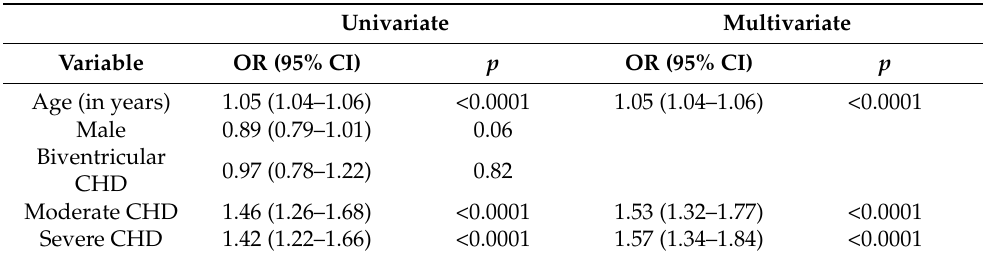
Table 3. Association between age, complexity of CHD, and gender with presence of at least one comorbidity. Univariate Multivariate